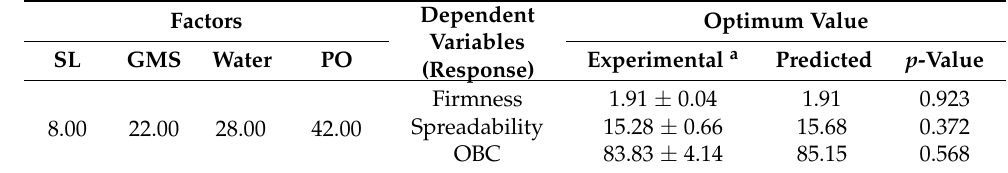
Table 3. Optimum formulation composition, comparison of experimental results with predicted response.